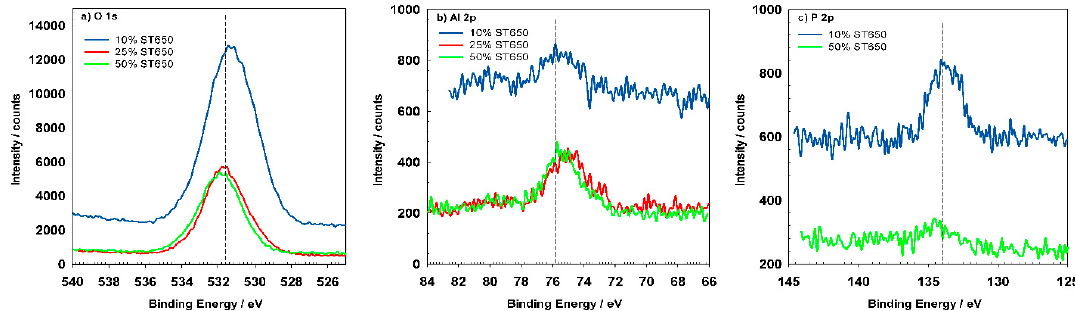
Figure 10. High-resolution XPS spectra of ( a ) O 1s ; ( b ) Al 2p ; ( c ) P 2p recorded for AA3003 samples coated with ST650 conversion coatings of different concentrations: 10%, 25% and 50%. The conversion time was 18 min at room temperature. Spectra were not normalized on the intensity scale.